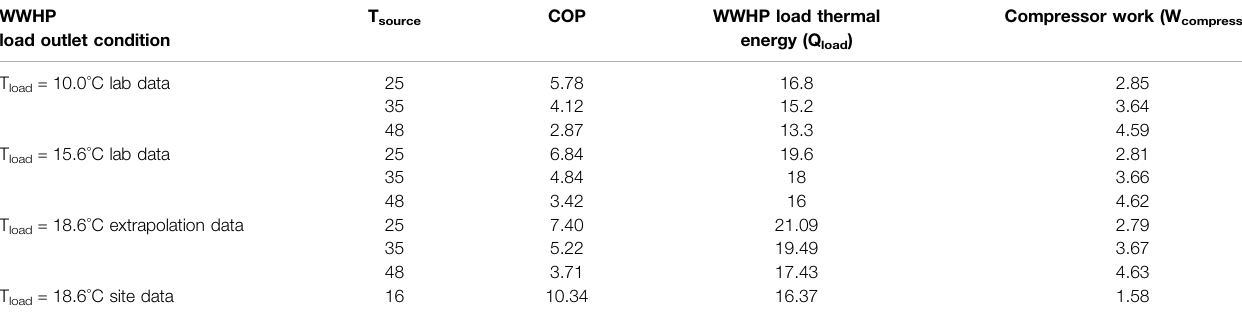
TABLE 6 | WWHP lab vs. demonstration site heat pump performance (COP) comparison